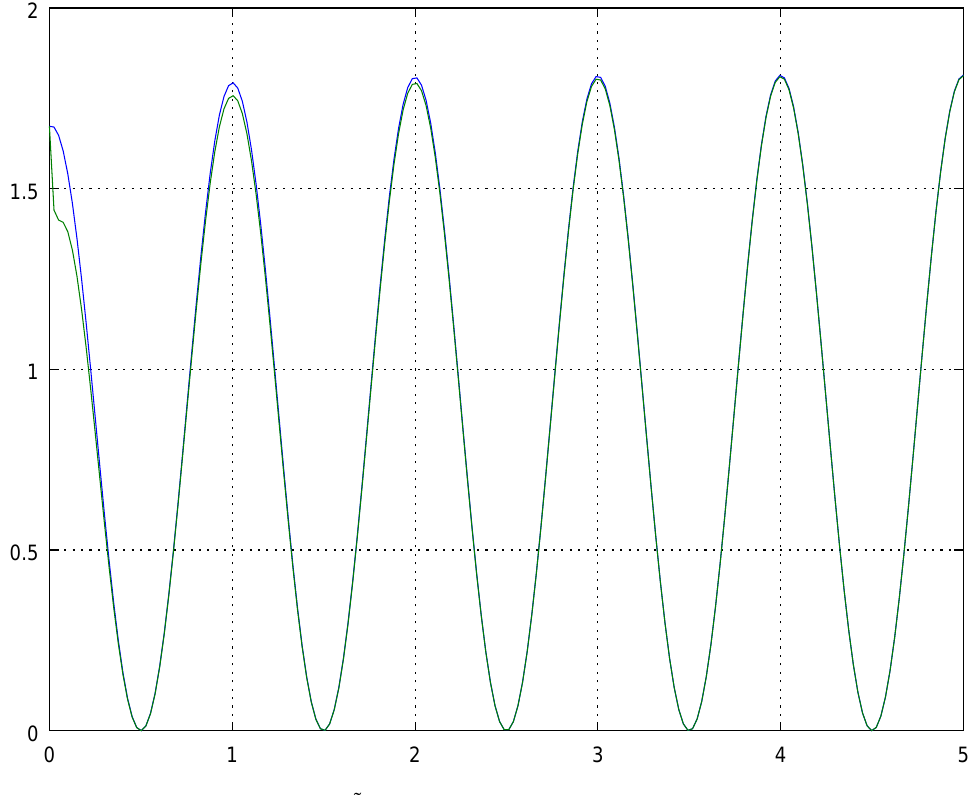
Figure 5. ˜ λ 1 under initial conditions (i) and